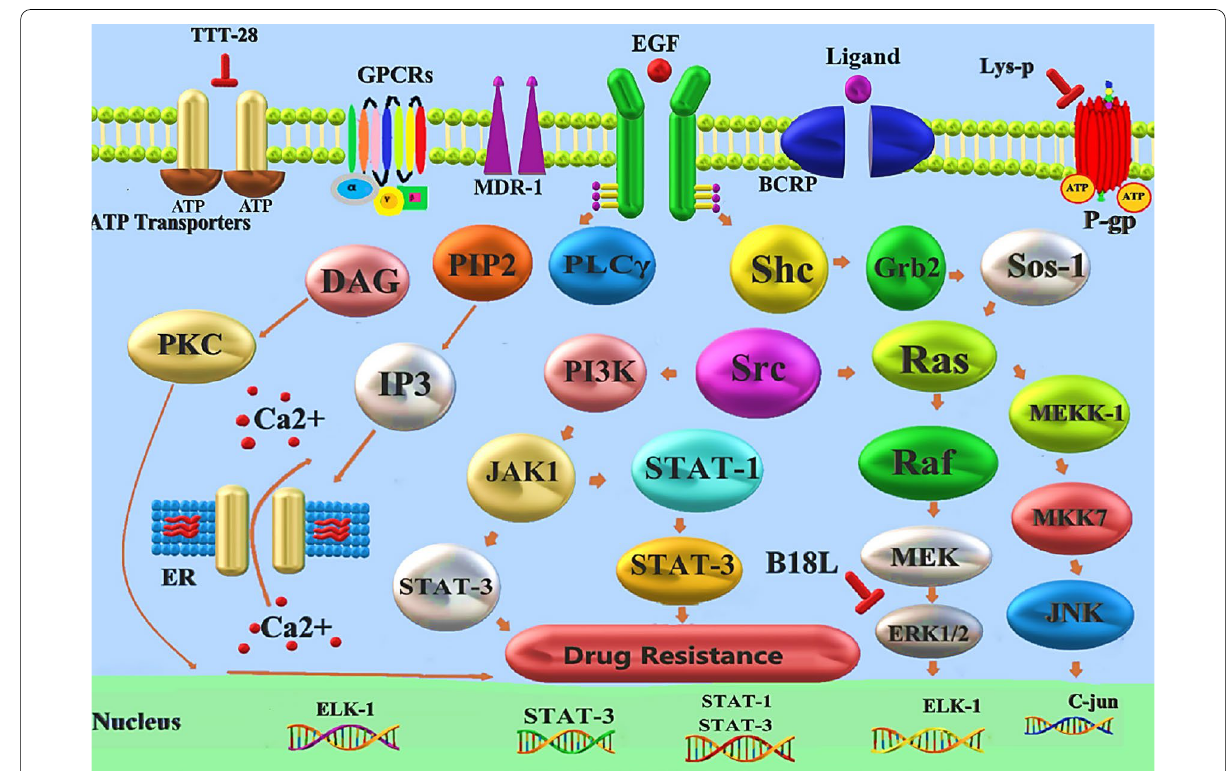
Fig. 5 Targeting drug resistance pathways by utilizing